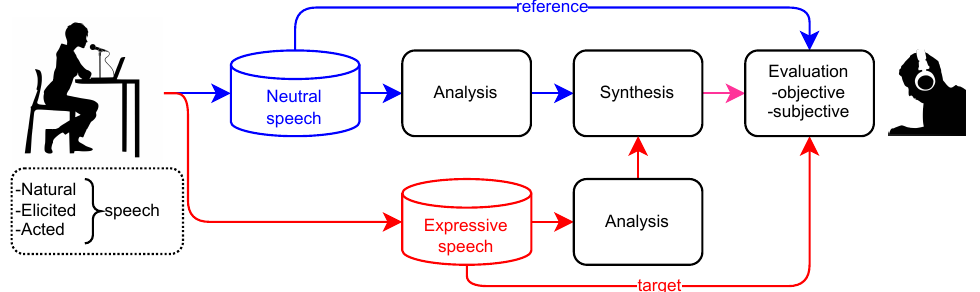
Figure 1. Workflow diagram of the analysis-by-synthesis approach applied to expressive speech. Neu- tral speech utterances are analysed to extract features that are manipulated according to the analysed expressive utterances to obtain resynthesised expressive stimuli. The results are objectively and/or subjectively evaluated in comparison with the non-expressive reference and the expressive